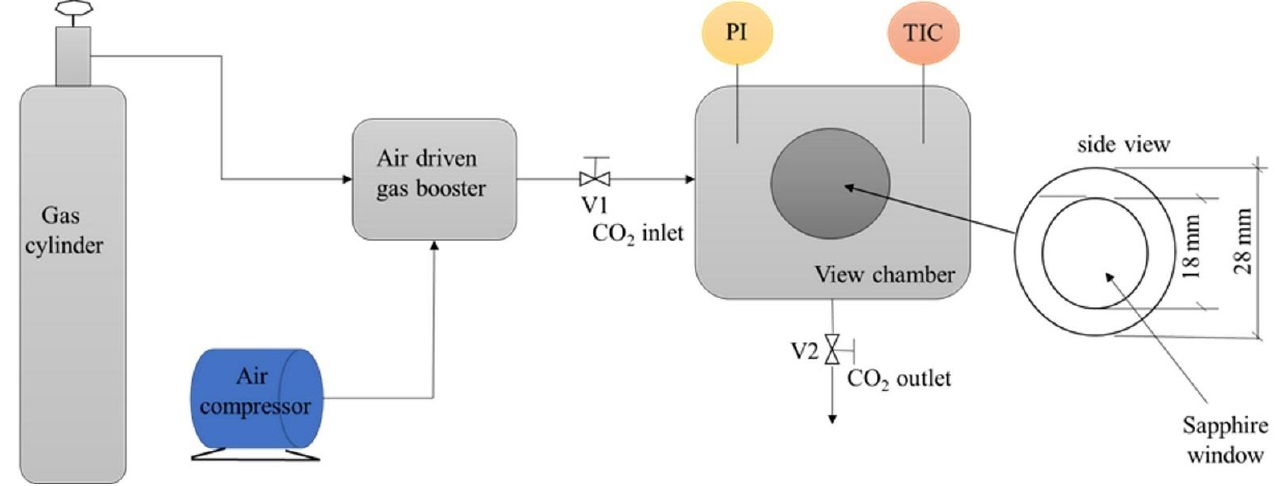
Figure 2. Scheme of the experimental setup used for one-step batch foaming and impregnation as-